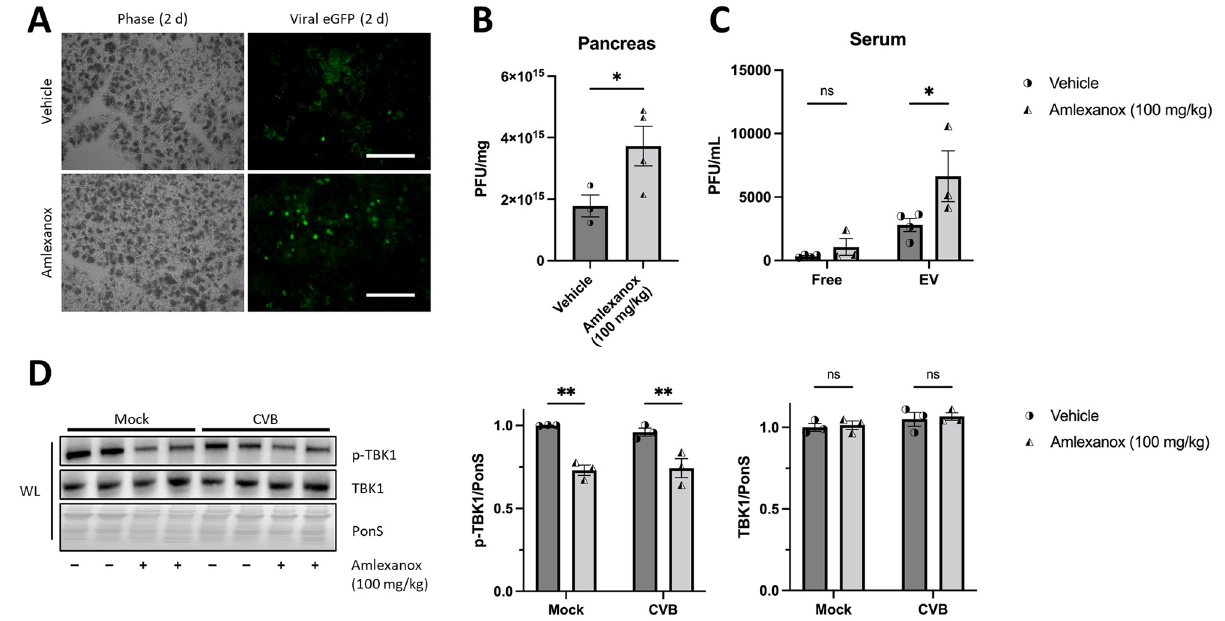
Fig 8. In vivo Amlexanox treatment increases pancreatic CVB titers and serum EV titers in CVB-infected mice. Ten-week-old C75BL/6 male mice were treated with 100 mg/kg Amlexanox or equal volume vehicle for 5 days pre-infection and each day following infection via oral gavage. On the fifth day of Amlexanox treatment, mice were infected I.P. with 10 7 plaque forming units (PFU) eGFP-CVB. (A) Fluorescence microscopy of cryo-frozen pancreata at 3d p.i. (B) Pancreatic viral titers as measured by plaque assays on pancreatic homogenates. � , p < 0.05, Student t test; n = 3–4. (C) Isolated free or EV viral titers as measured by plaque assays from serum. � , p < 0.05, two-way ANOVA; n = 3–4. Data are representative of 3 experiments. (D) Western blot of mouse pancreata isolated at 2 days p.i. �� , p < 0.01, two-way ANOVA; n = 3–4. WL = whole lysate.